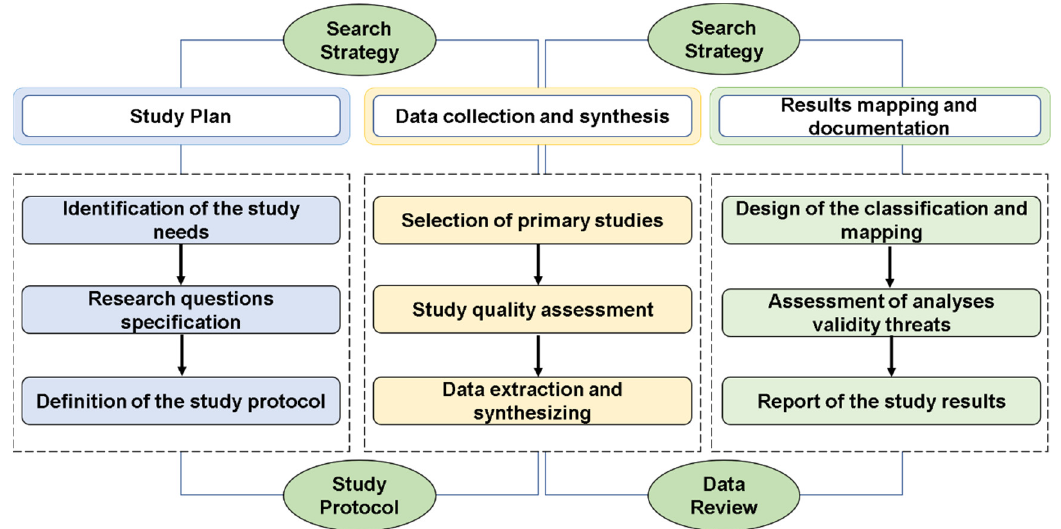
Figure 1. Steps followed in the systematic review (SR) research methodology.